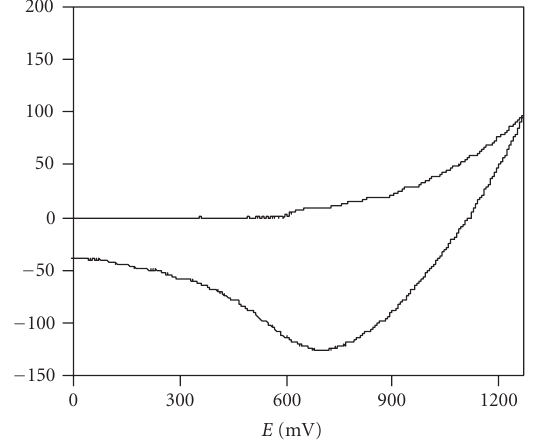
HOMO of low MW PTEBS is approximately − 4 . 7eV ∼ − 5 . 1eV and its LUMO is about − 2 . 7eV ∼ − 3 . 1eV, utilizing